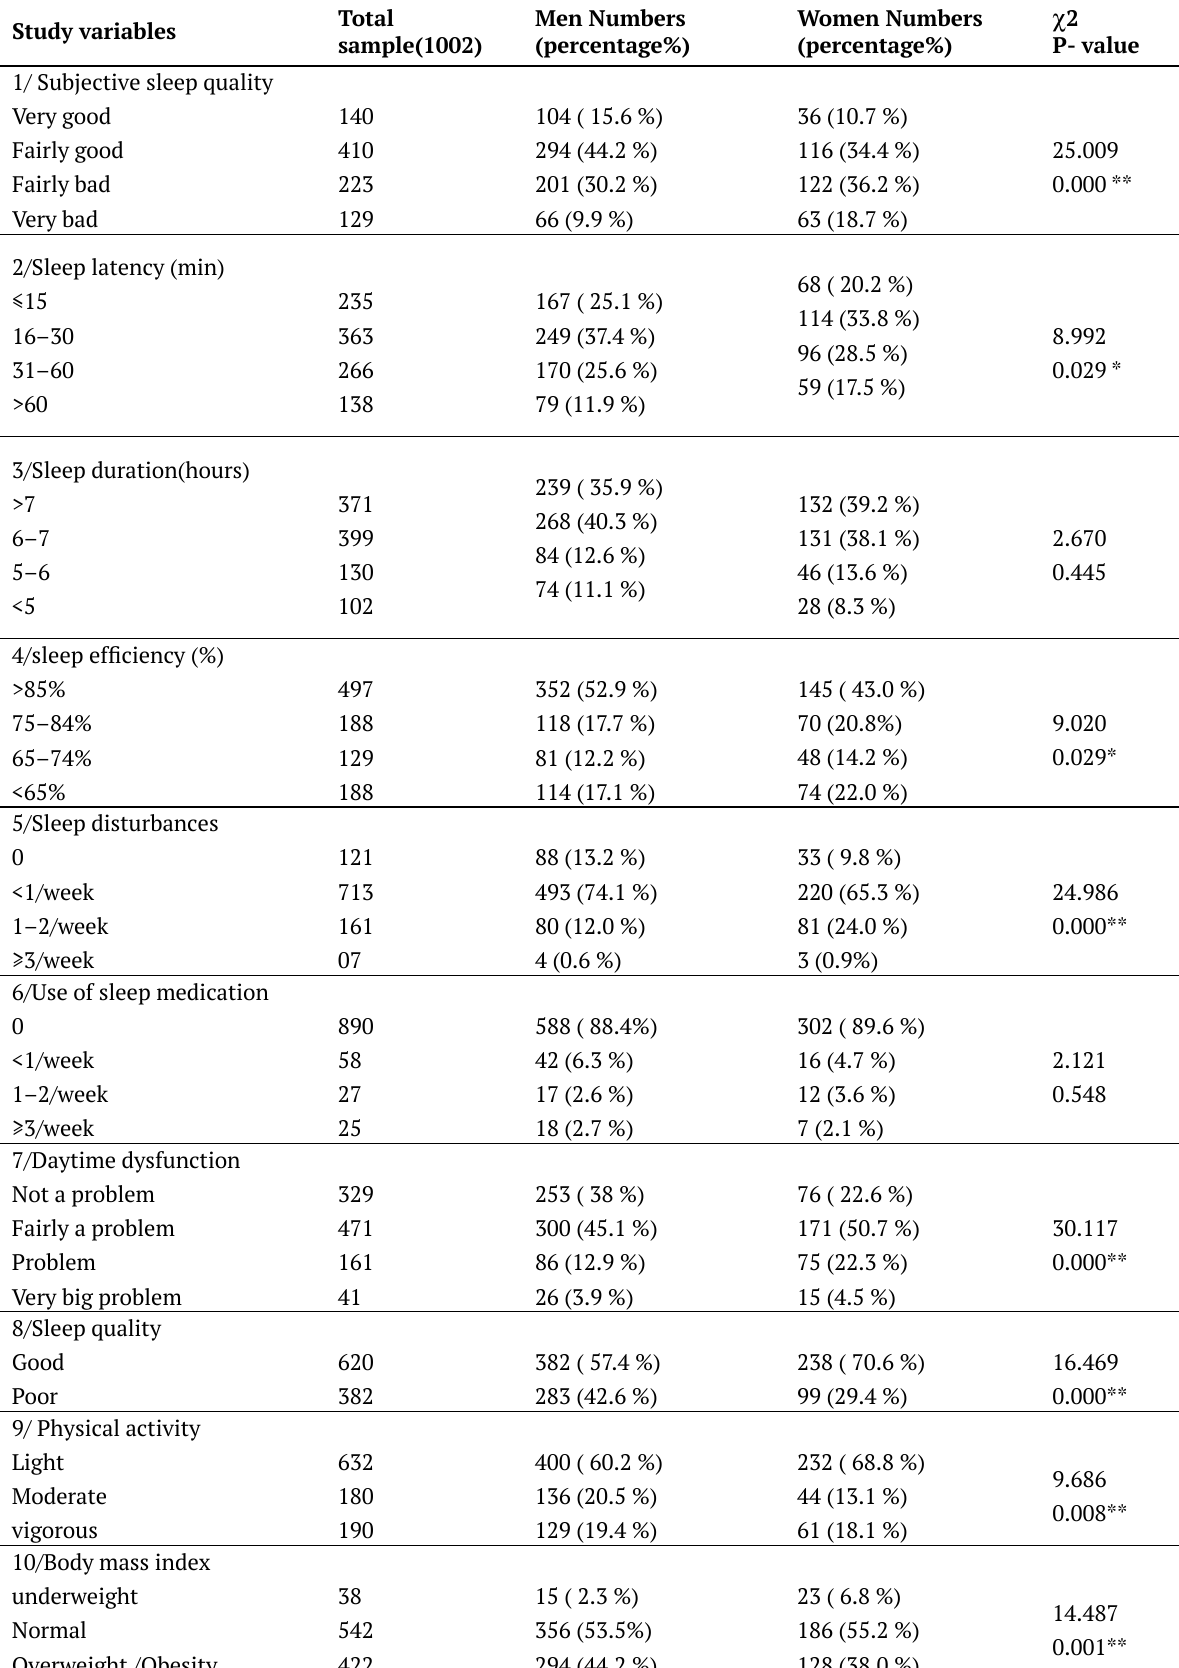
Table 2. Characteristics of the study participants, stratified by gender